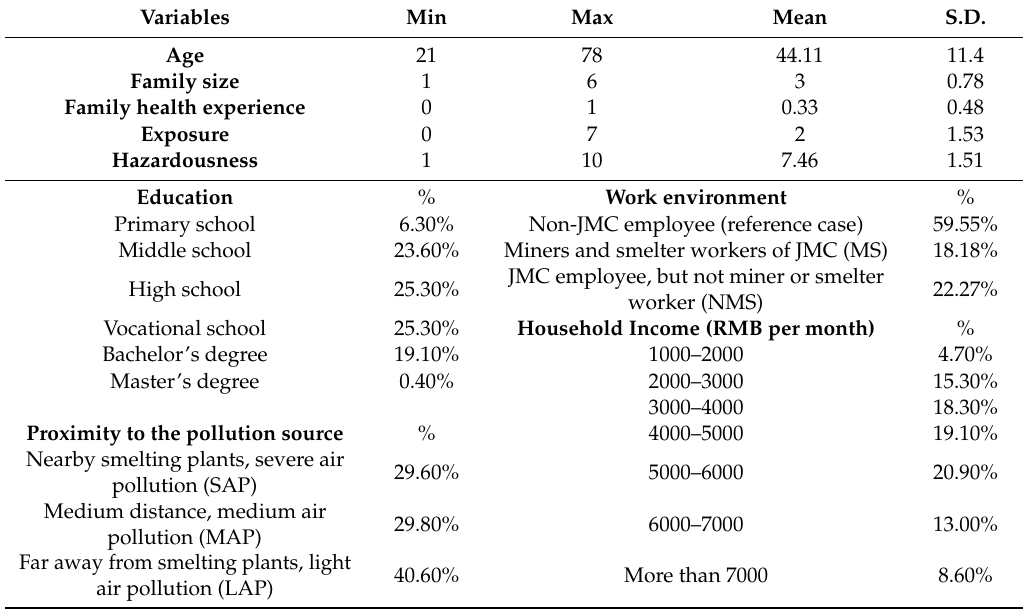
Table 3. Descriptive statistics for the observed exogenous